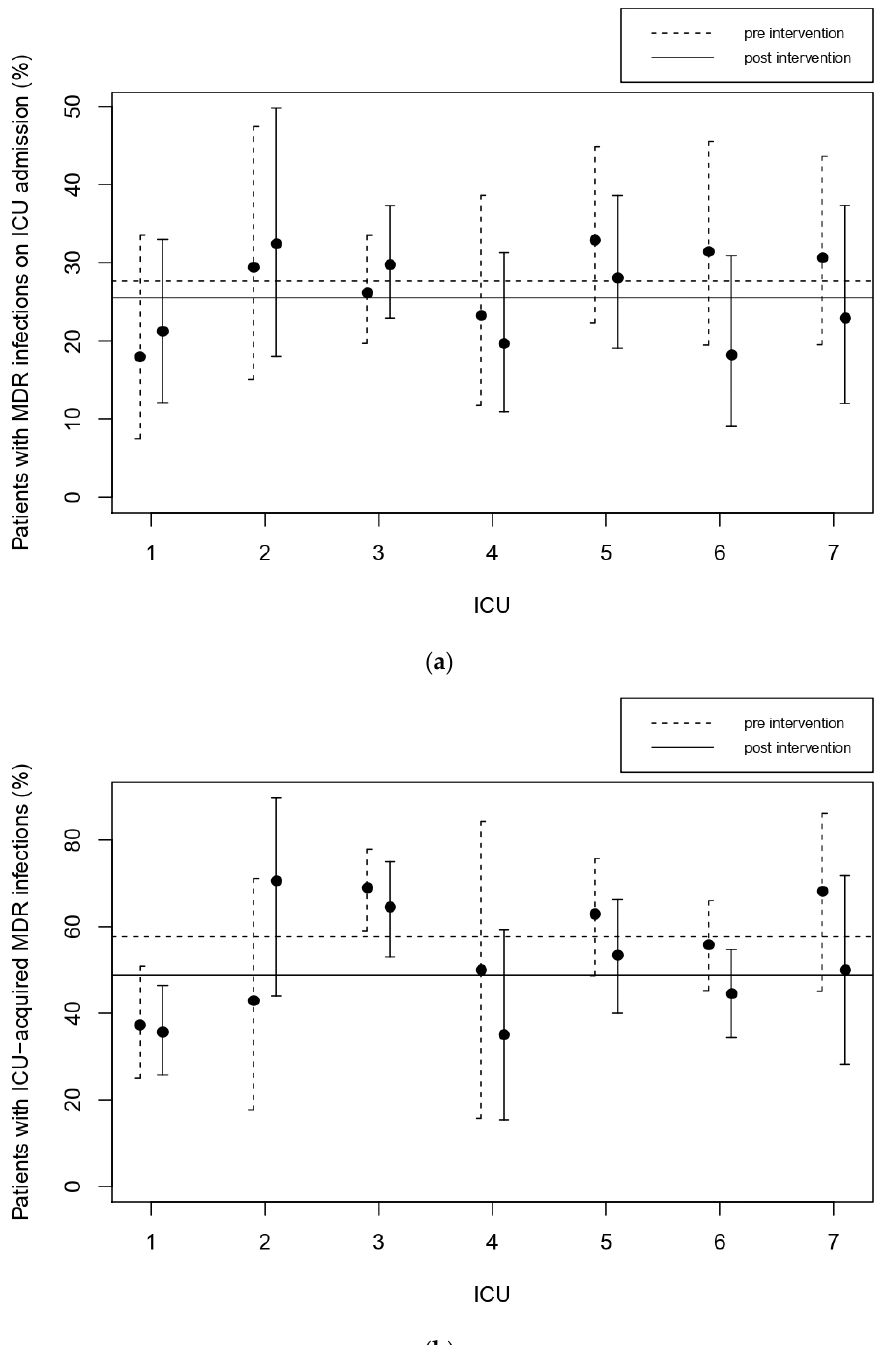
Figure 1. %MDR on admission (panel ( a )) and %MDR in ICU ‐ acquired infections (>48 h, panel ( b )) for the participating centers, pre ‐ (dashed line) and post ‐ intervention (solid line). The horizontal line indicates the average.